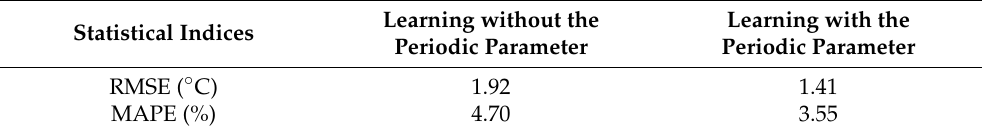
3.3. A Comparative Evaluation of the RNN Models according to the Order of Learning Data